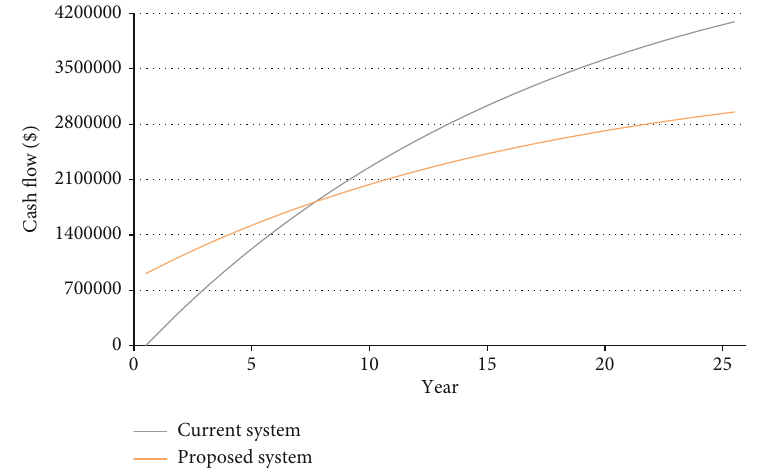
Figure 33: Cumulative cash fl ows over the project lifetime for the current and proposed systems for Burundi.